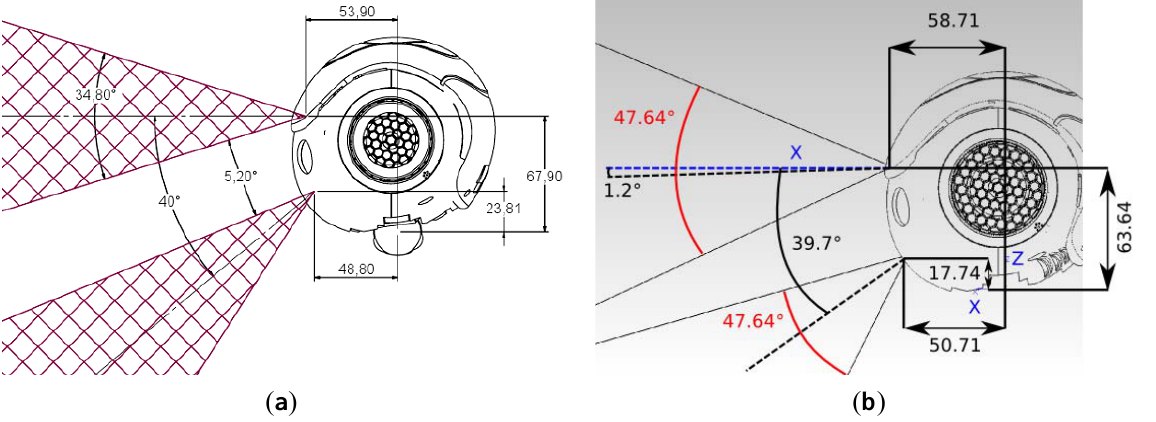
Figure 3. Camera placement in a Nao robot. Side views of the head camera layout. Note the field of view (FOV) of each camera: ( a ) Nao V3, ( b ) Nao